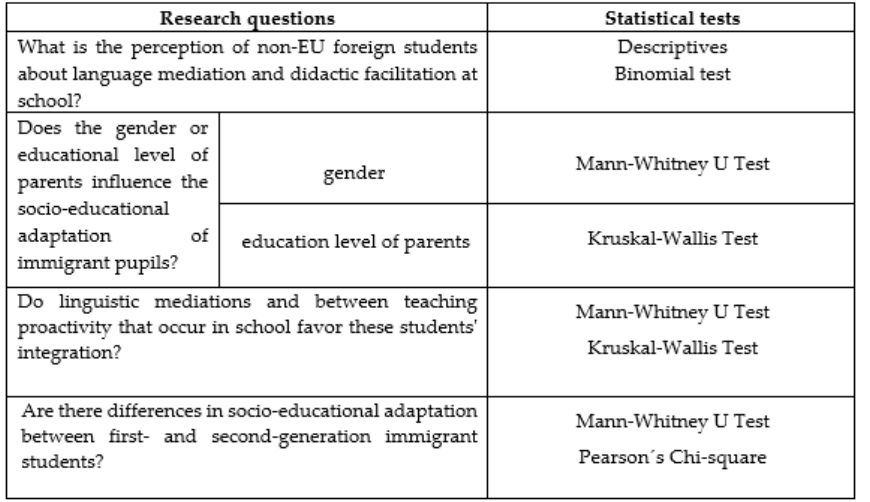
Figure 1. Relationship questions and statistical tests.